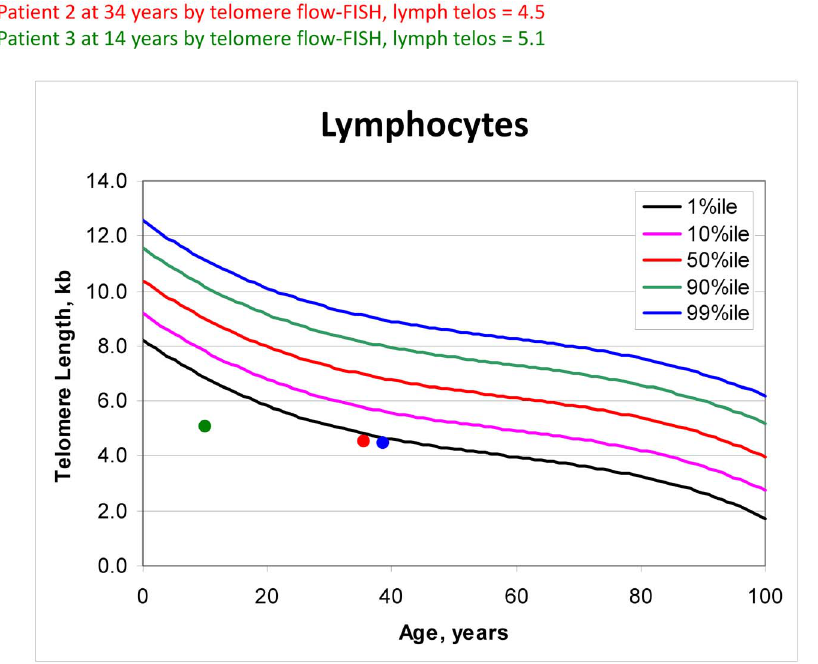
Figure 6. Median telomere lengths in lymphocytes, as determined by flow cytometry with fluorescent insitu hybridization (flow FISH). Patients 1 (two time points), 2 and 3 are plotted against population norms. yrs = years; MTL = median telomere length; kb = kilobase